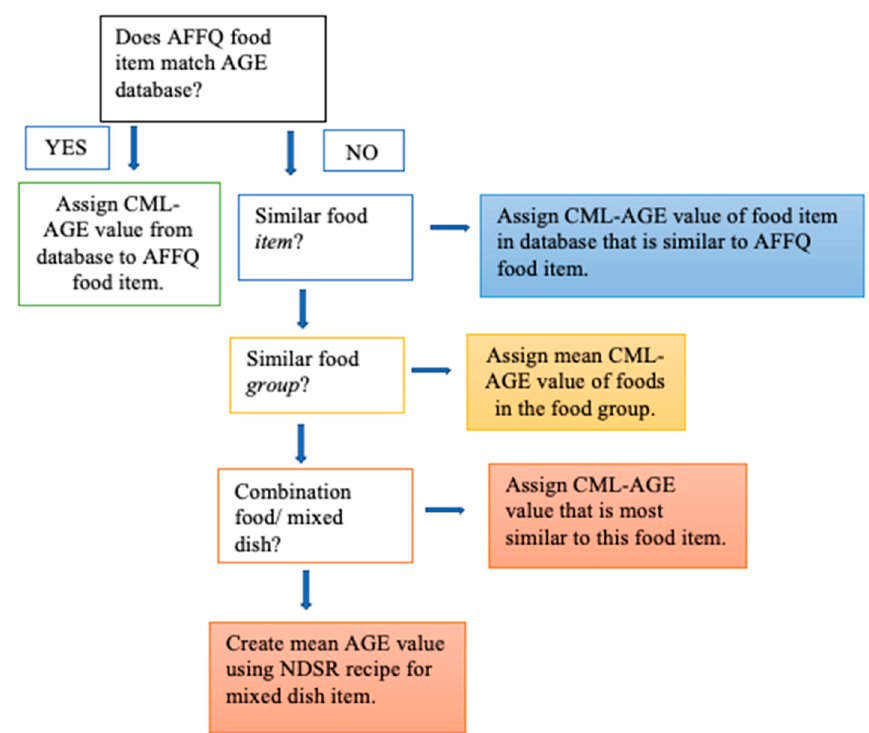
Figure 2. Flow diagram describing the protocol for CML-AGE database assignment to AFFQ food item. Food items within the AFFQ were assigned CML-AGE values using a published database. Food items from the AFFQ that weren’t found in the published data base were assigned average CML